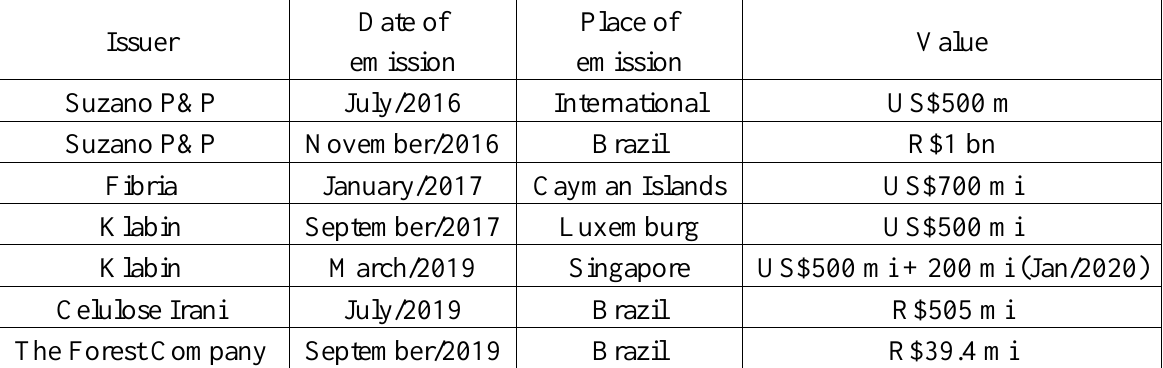
Table 1: Green bonds emissions in the Brazilian forestry